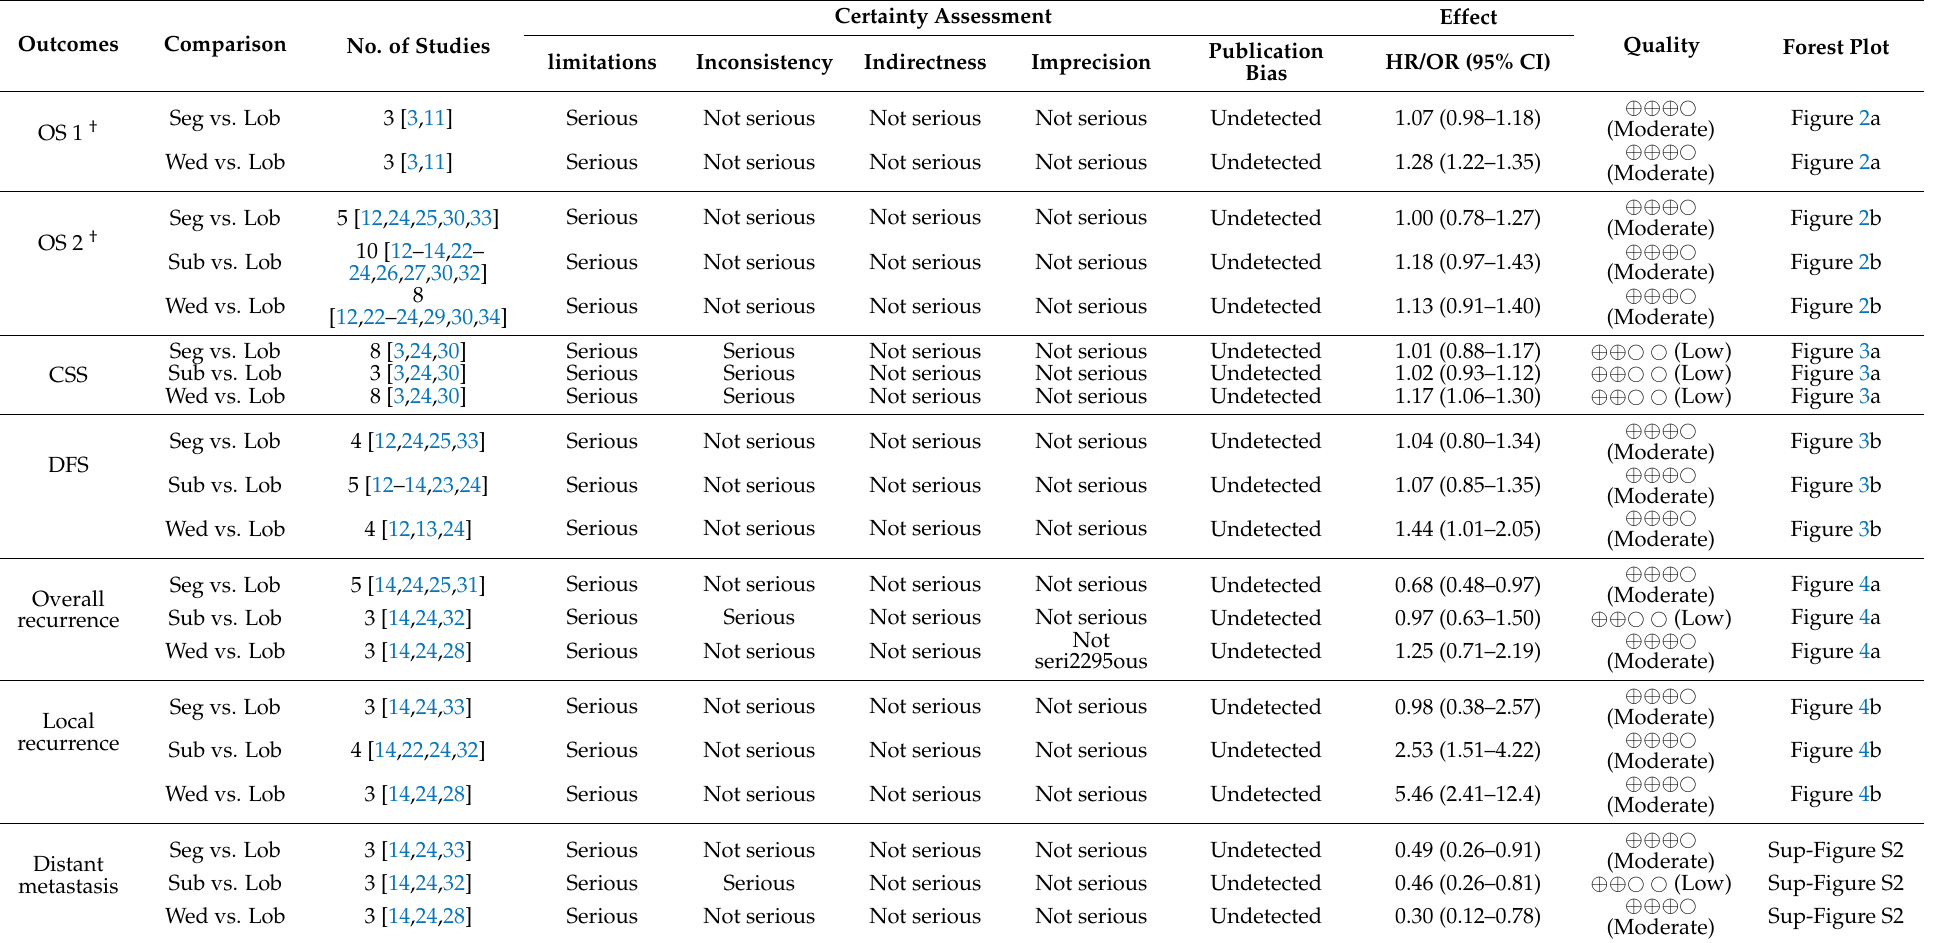
Table 2. GRADE evidence profile: meta-analyses of surgical resections and